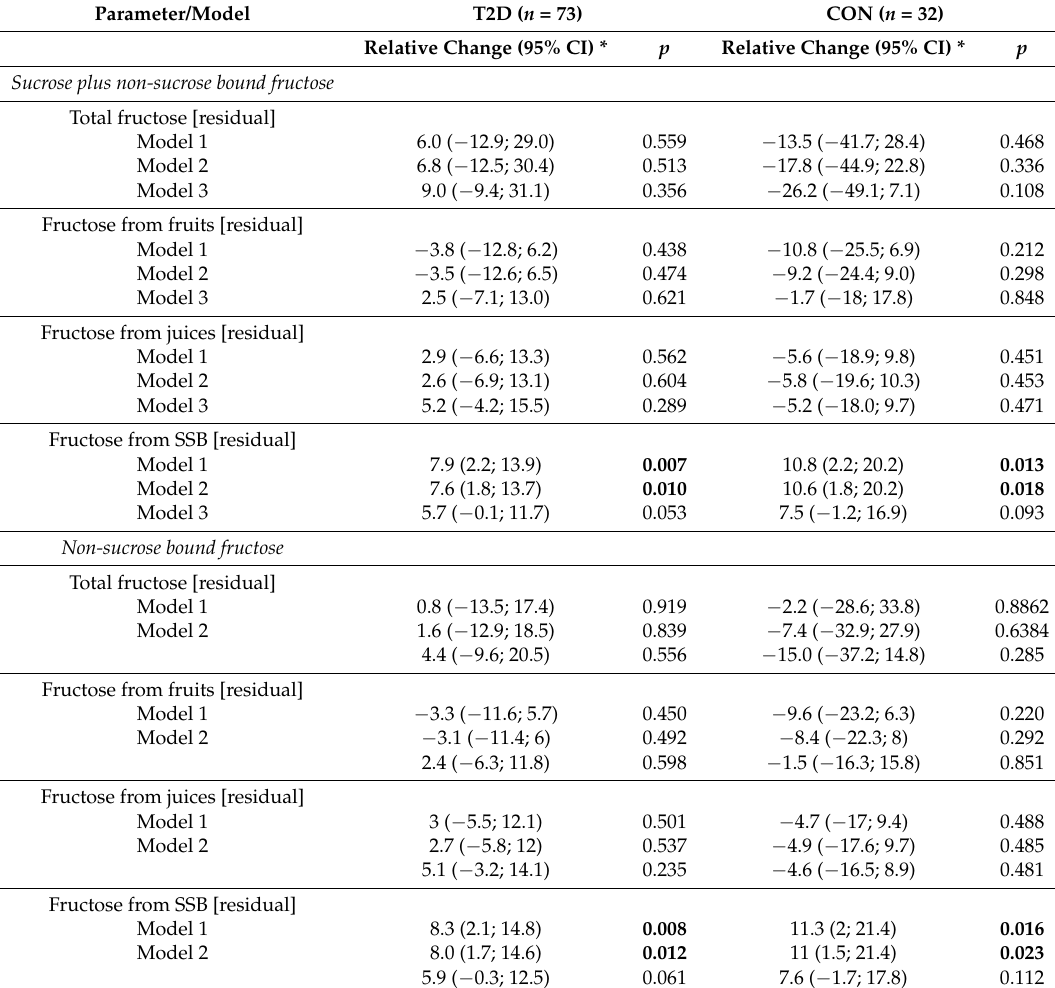
Table 5. Association of fructose intake with hepatic insulin resistance index in patients with type 2 diabetes and individuals without